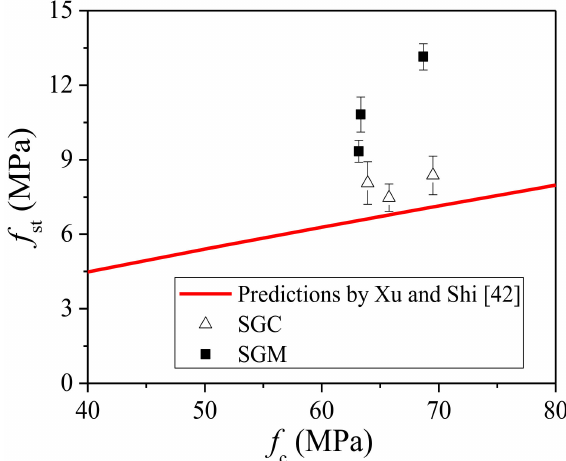
Figure 4. Relationship between splitting tensile strength and compressive strength of steel fiber-reinforced SGM/SGC.